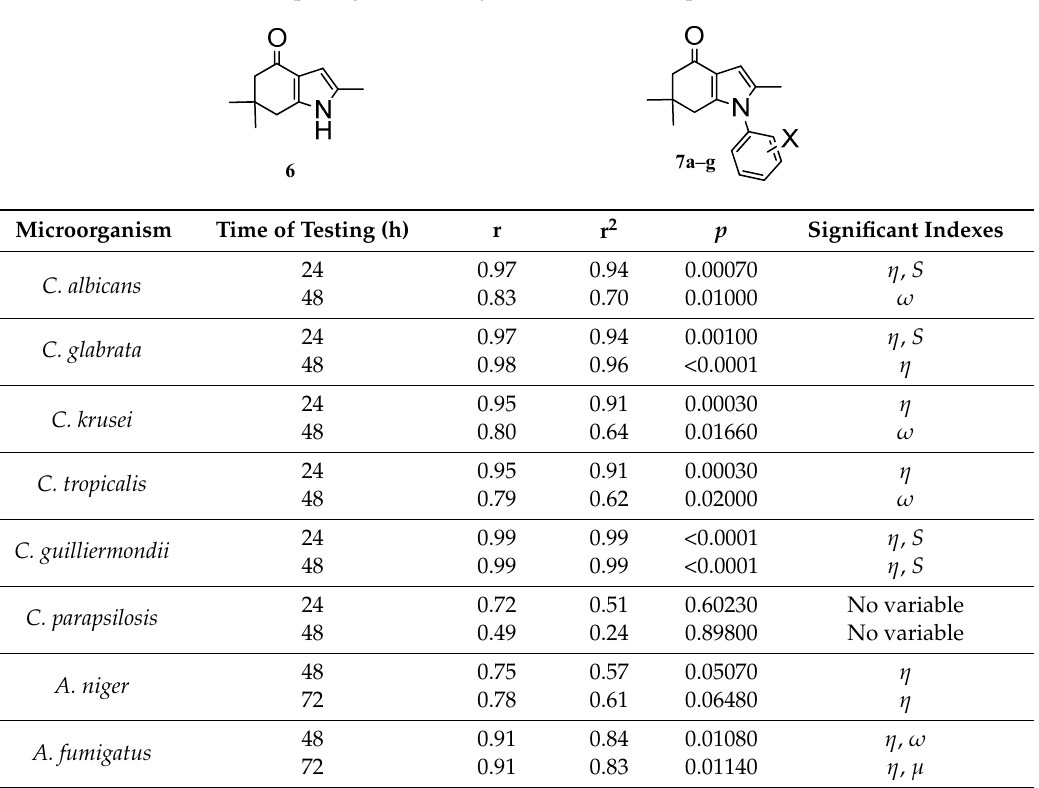
Table 5. Multiple regression analysis for series I: Compounds 6 and 7a – g .